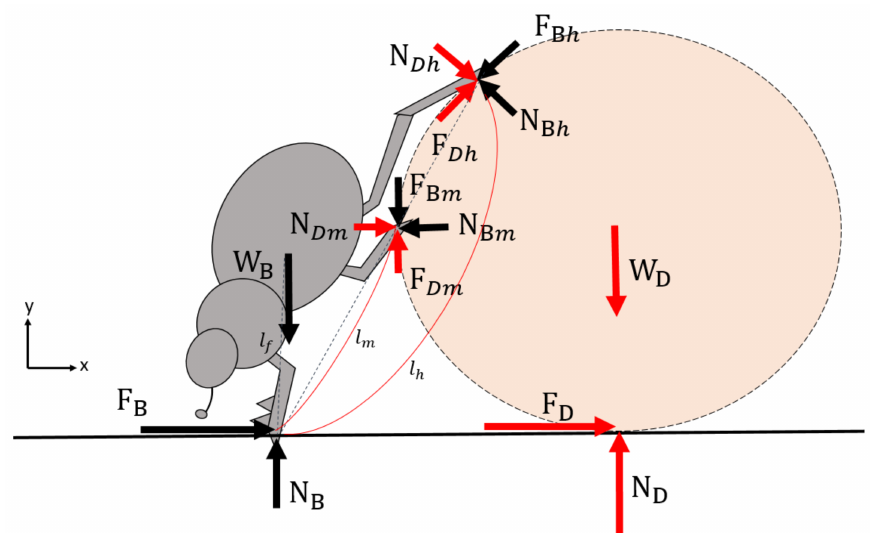
Figure 3. Free body diagram of the dung beetle and dung. Red arrows indicate forces act on dung. Black arrows indicate forces act on beetle. W B : weight of the beetle, W D : weight of the dung, F B : ground friction acting on the beetle, F D : ground friction acting on the dung, N B : normal force acting on the beetle, N D : normal force acting on the dung, F B h : friction acting on the beetle at the hind-leg, and N Dm : Normal force acting on the dung at the